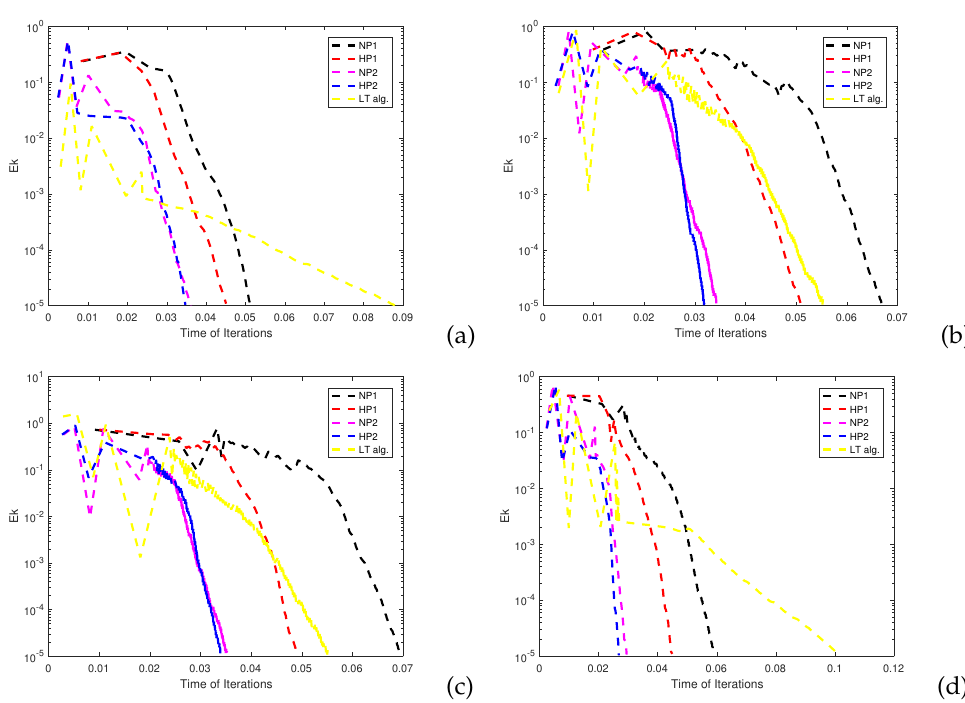
Figure 3. Comparison of CPU times of the algorithms in Example 1: ( a ) Comparison for choice 1. ( b ) Comparison for choice 2. ( c ) Comparison for choice 3. ( d ) Comparison for choice 4.